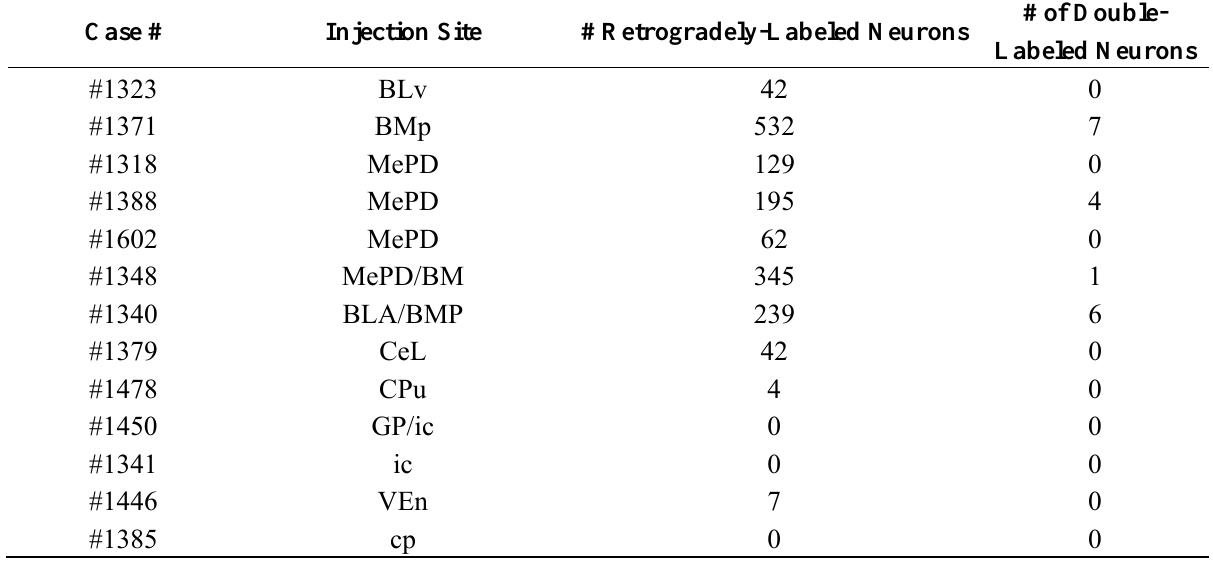
Table 2. Location of iontophoretic injections and retrogradely-labeled